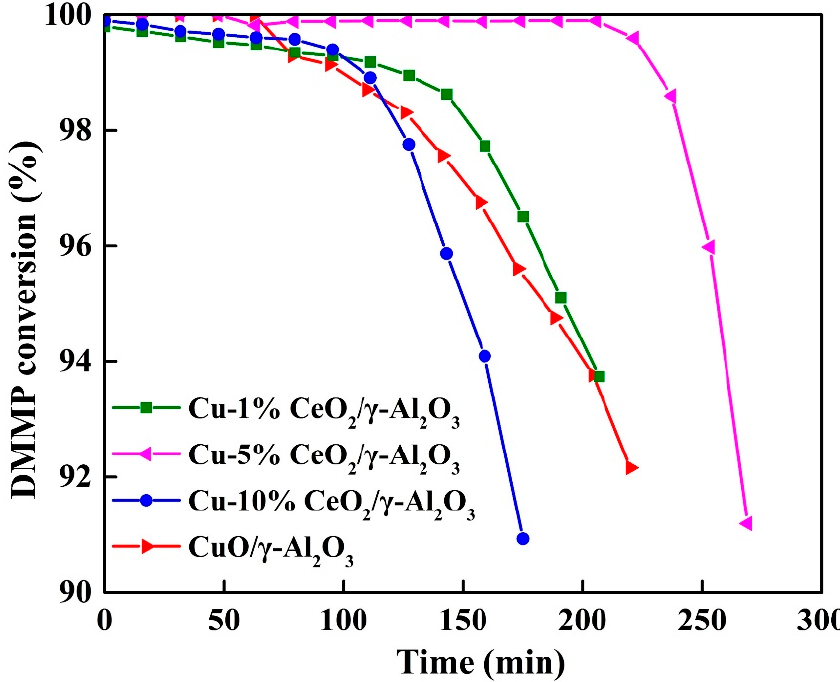
Figure 2. Effects of different Cu/Ce ratios of the CuO/CeO 2 / γ ‐ Al 2 O 3 catalysts on protection time.